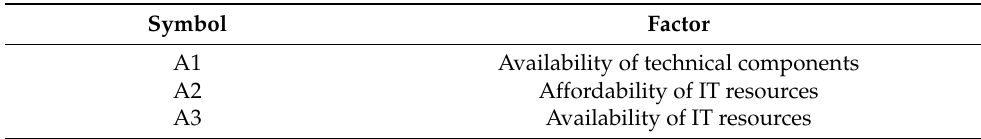
Table 1. Blockchain Technology Adoption Readiness Factors at Sultan Ageng Tirtayasa University